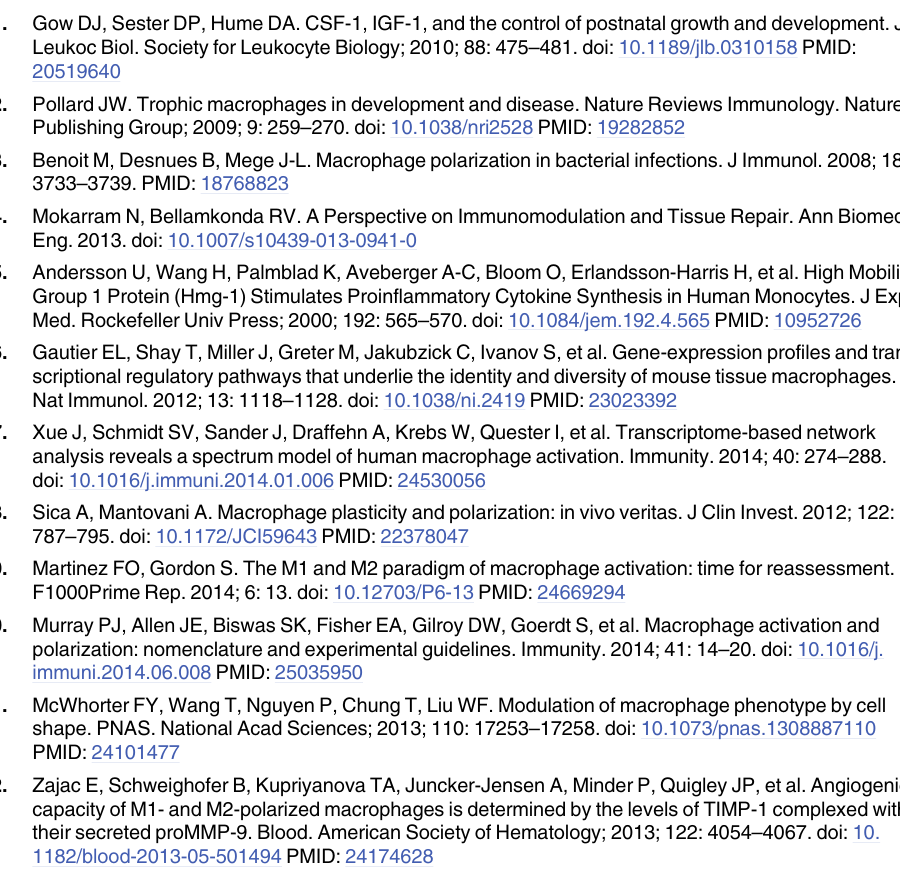
S3 Table. M1 macrophage markers compared between WT M1vs. WT M0 and KO M1 vs. KO M0 macrophages. S4 Table. M2 macrophage markers compared between WT M1vs. WT M0 and KO M1 vs. KO M0 macrophages. S5 Table. miR-155 targets down-regulated in WT M1 vs. WT